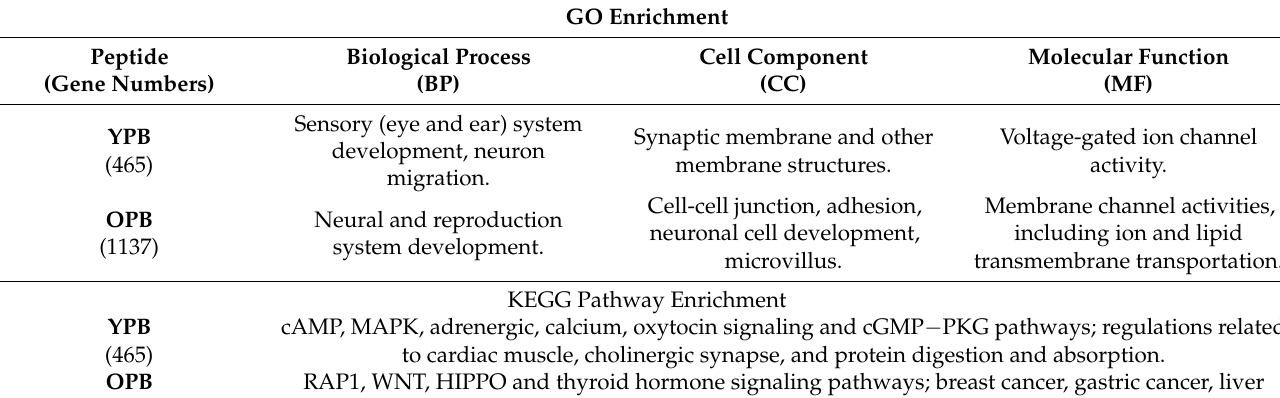
Table 1. Summary of GO and KEGG pathway enrichment analyses of the H3K27me3 changes in MDA-MB-231 cells treated by YPB and OPB peptides versus Cont